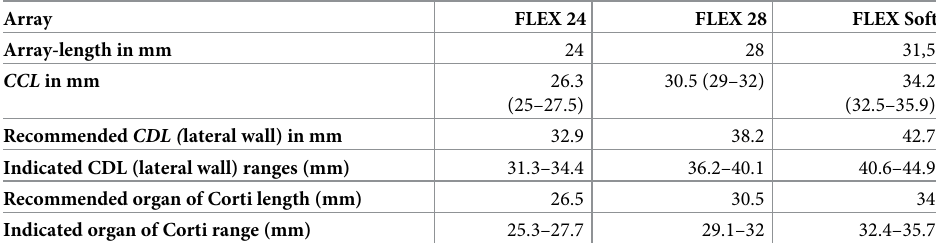
Table 1. Indication range for the FLEX electrodes.